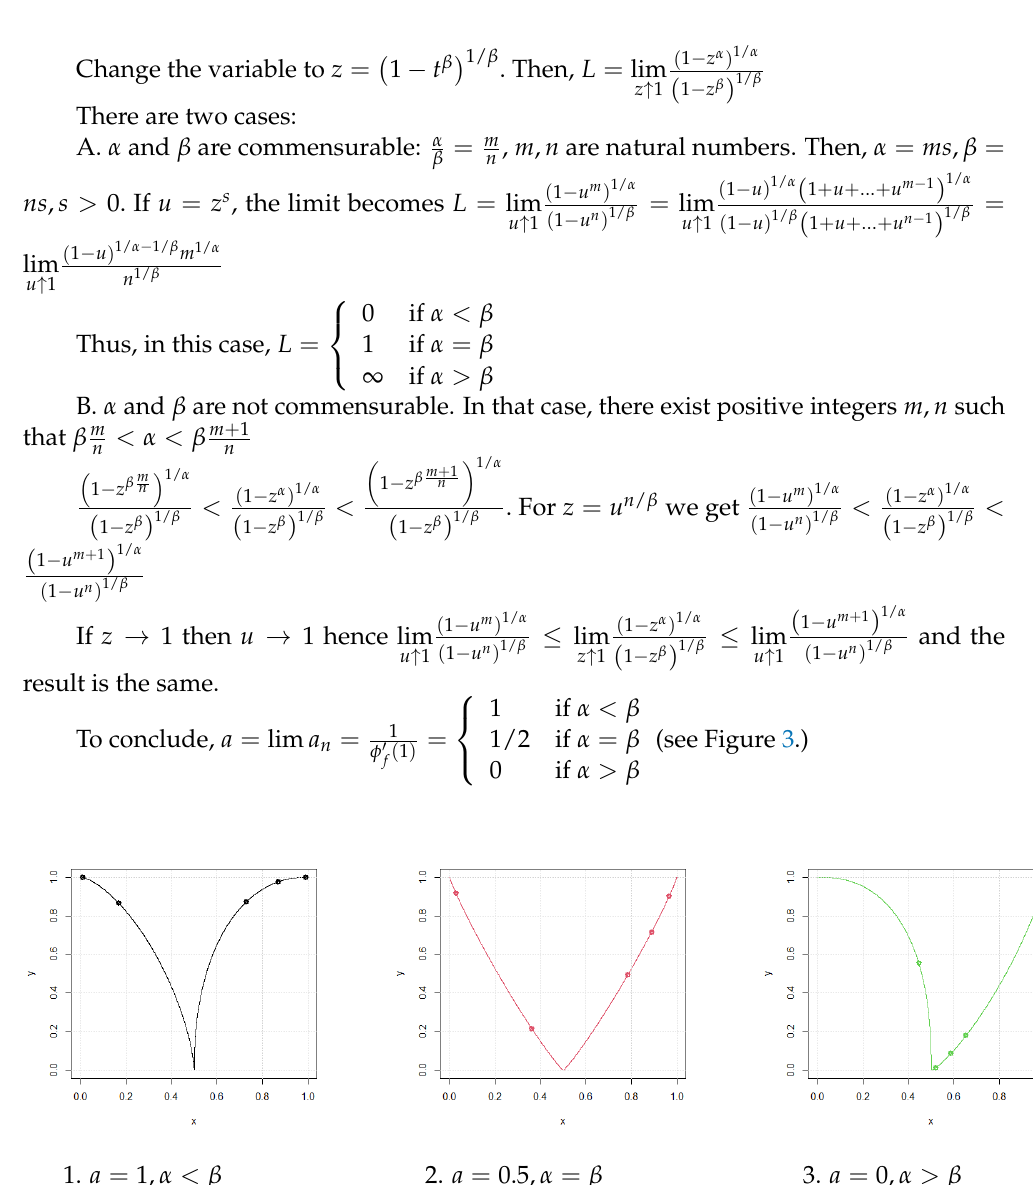
Figure 3. Example